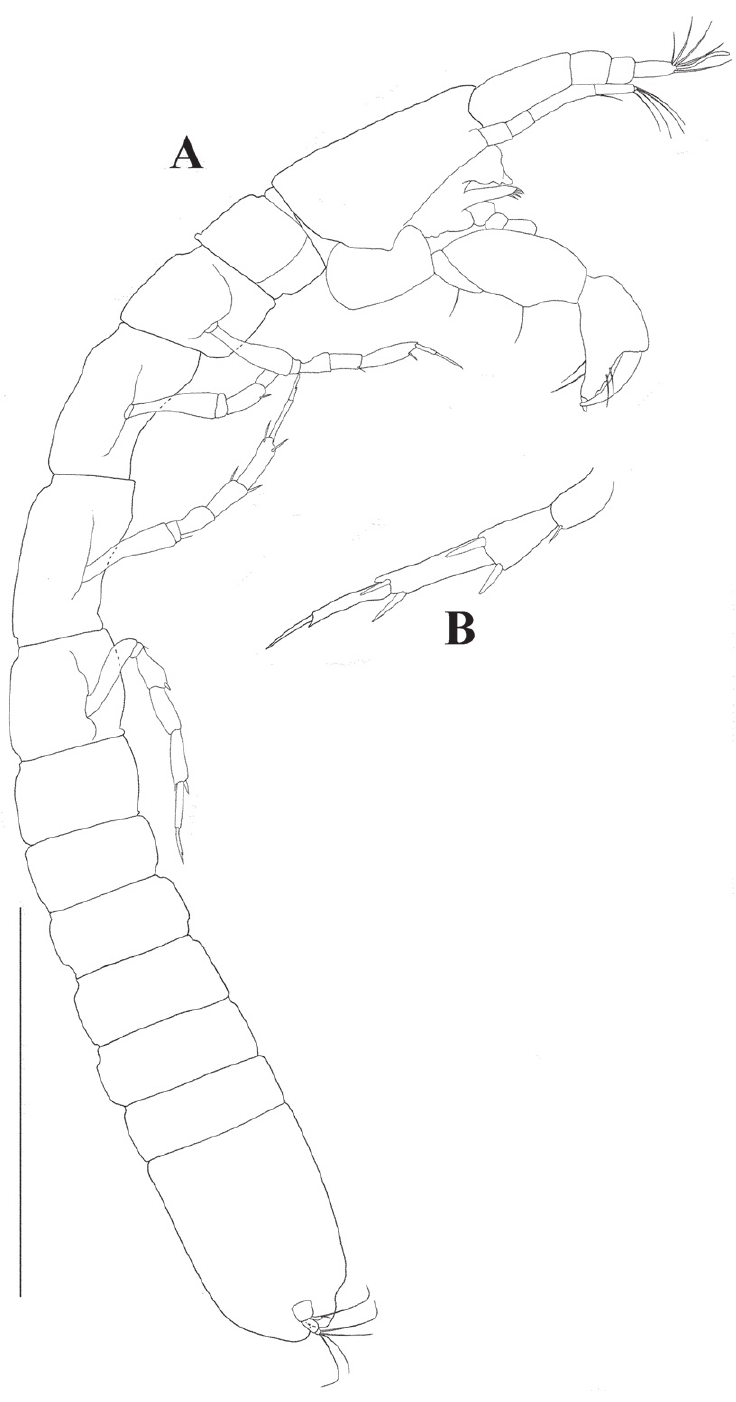
Figure 4. Collettea sp A lateral view, scale bar = 0.5 mm B tip of pereopod 4, scale bar = 0.5